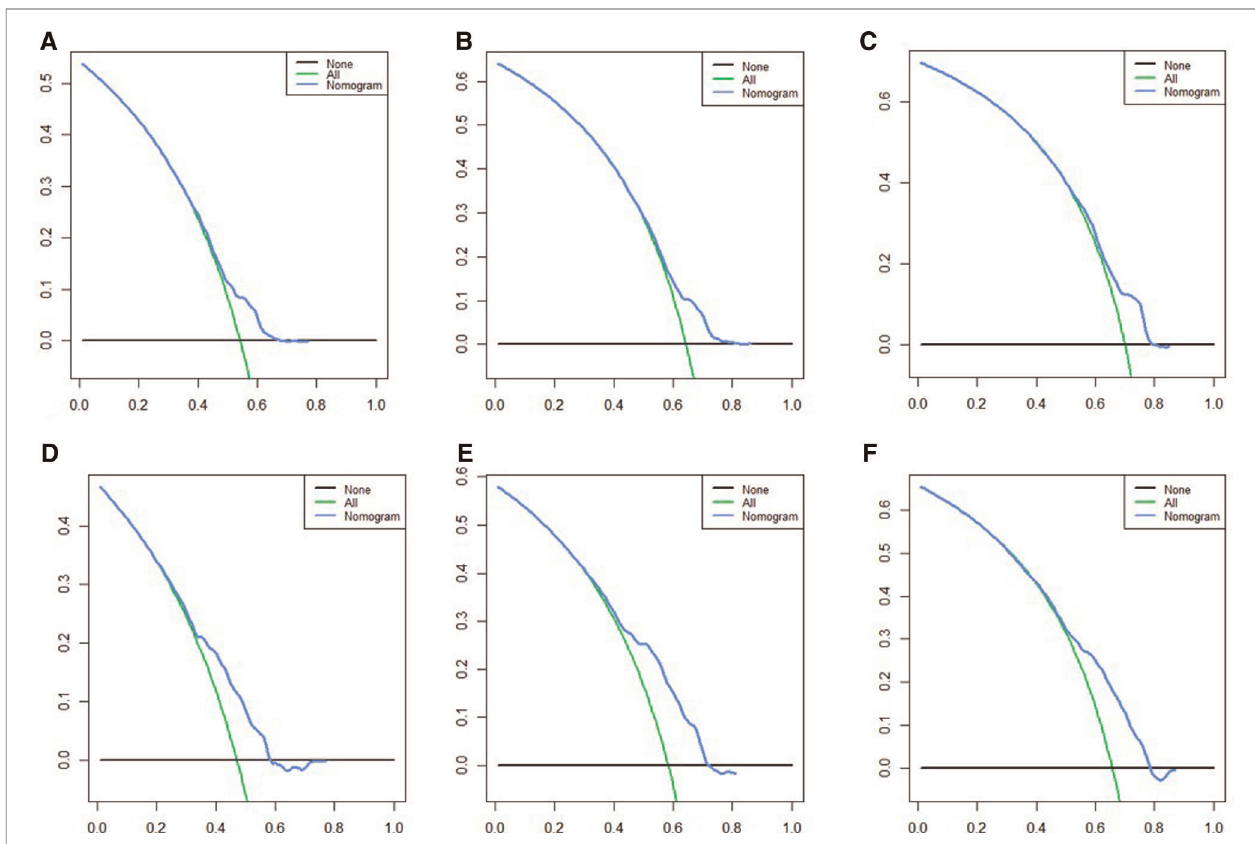
FIGURE 6 | DCA for survival prediction. ( A ) DCA of 36 months in the training cohort, ( B ) DCA of 60 months in the training cohort, ( C ) DCA of 84 months in the training cohort, ( D ) DCA of 36 months in the validation cohort, ( E ) DCA of 60 months in the validation cohort, ( F ) DCA of 84 months in the validation cohort. DCA, decision curve